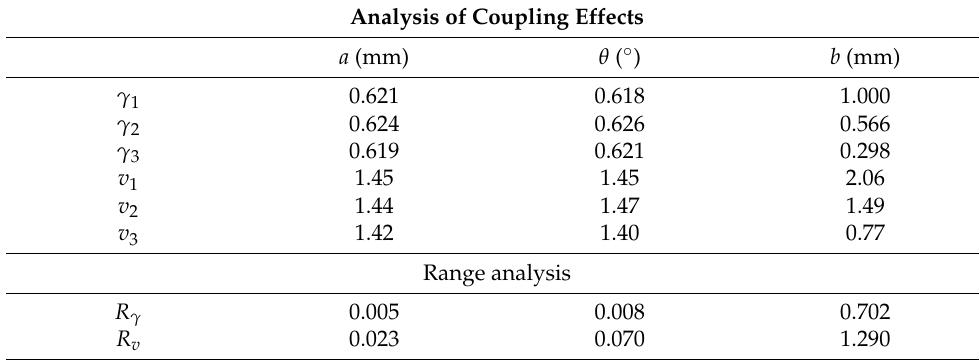
Figure 4. Coupling effects of mandrel axis length, inlet angle, and flute length on ( a ) solidification ratio and ( b ) velocity profile SD. Table 3. Analysis of coupling effects and range analysis of orthogonal experiments.